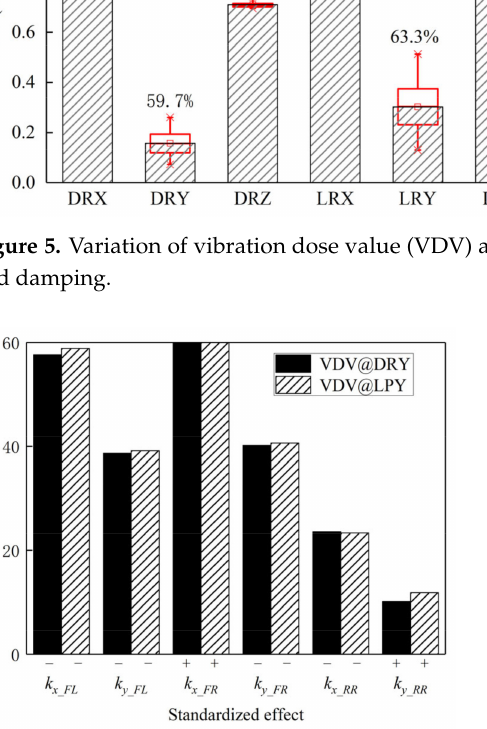
Figure 6. Standardized effects of significant parameters on the lateral VDV at seat